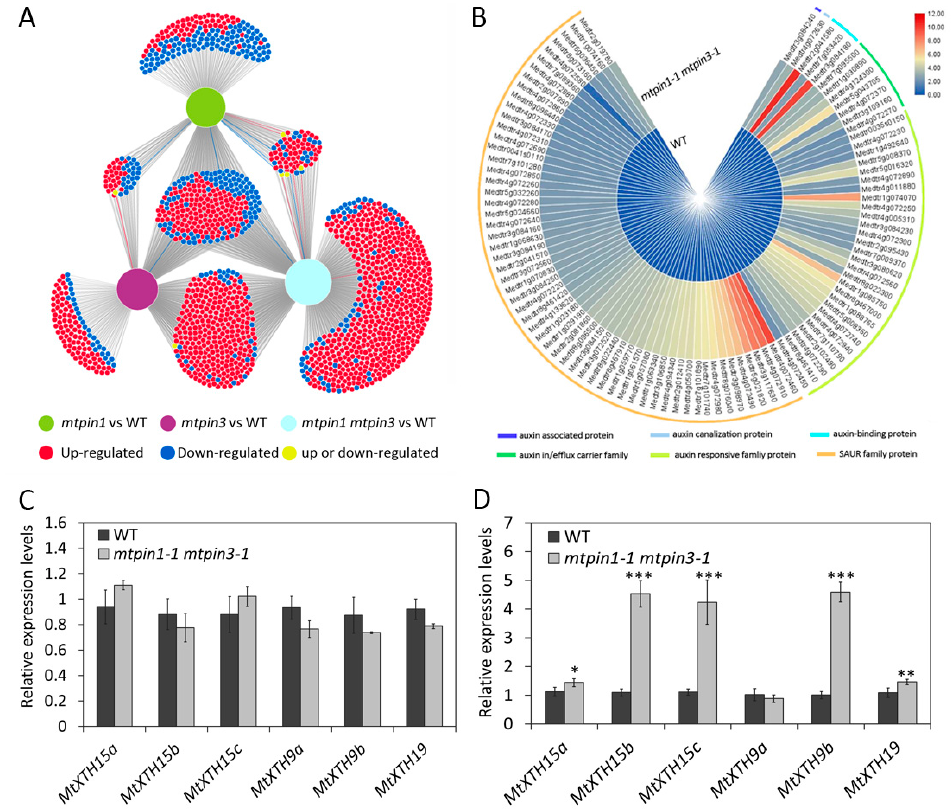
Figure 5. Transcriptomic profiles of wild-type and mutants. ( A ) The full set of DEGs identified in leaves of mtpin1-1 , mtpin3-1 , and mtpin1-1 mtpin3-1 . ( B ) The heatmap of auxin-related DEGs in mtpin1-1 mtpin3-1 . ( C , D ) Relative expression levels of MtXTH15a , MtXTH15b , MtXTH15c , MtXTH9a , MtXTH9b , and MtXTH19 , in the leaf ( C ) and petiole ( D ), in wild-type (WT) and mtpin1-1 mtpin3-1 . Values are the means and SD of three biological replicates. * p < 0.05, ** p < 0.01, *** p < 0.001. 2.7. Mtpin1 Mtpin3 Exhibit the Constitutive ShadeAvoidance Responses Phenotype under the Normal